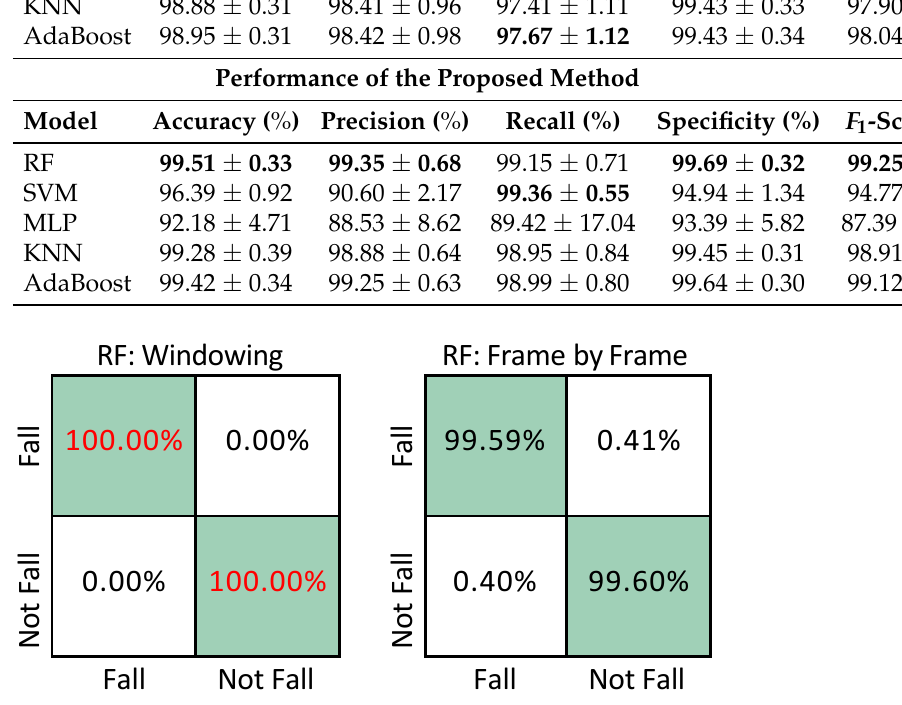
Figure 9. Comparison of confusion matrices for fall detection using UR-Fall: RF proposed method ( left ) vs. Frame-by-Frame+RF (right) [12]. Best results are shown in red.